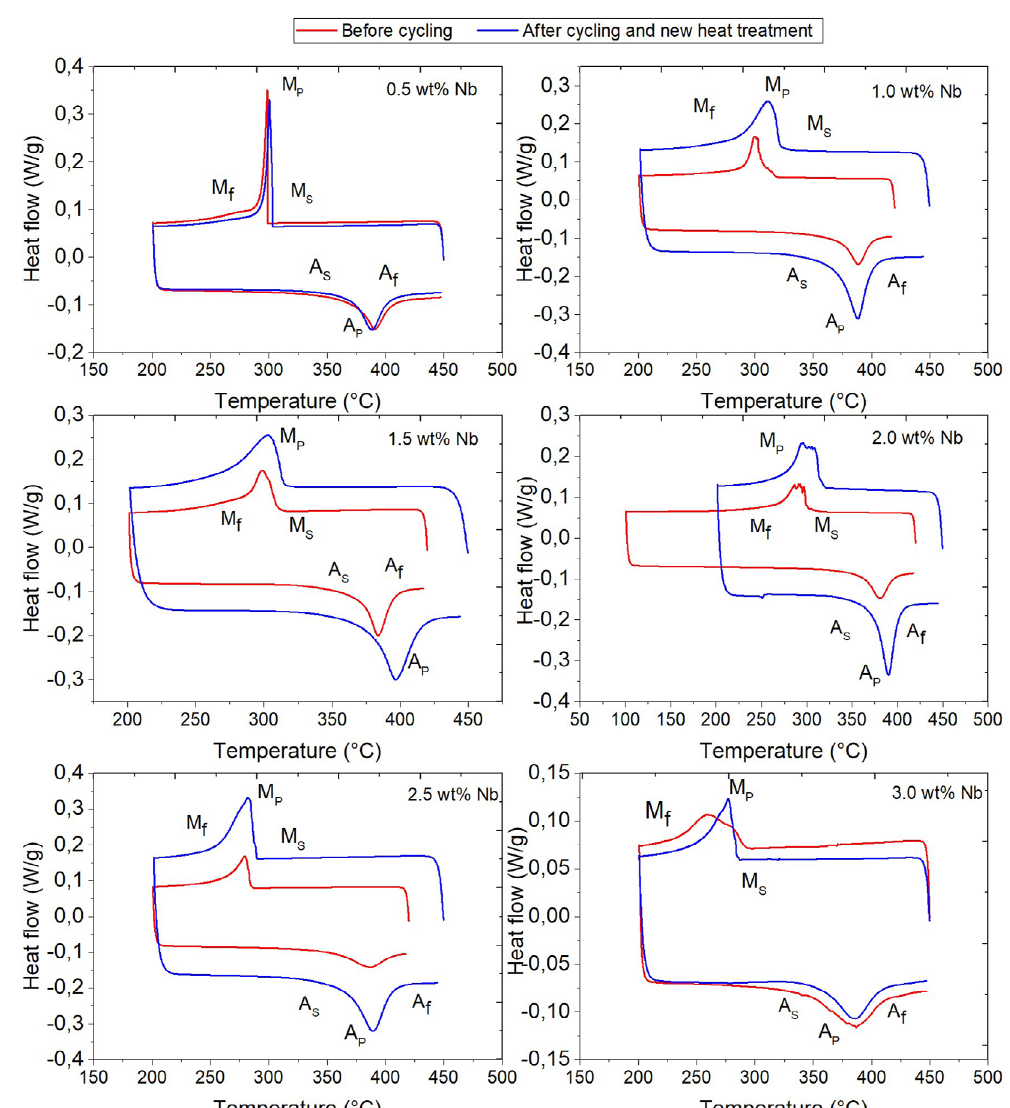
Figure 3. Superposition of DSC results before and after thermal cycling with phase martensitic transformation restoration through heat treatment for all Cu-Al-Nb HTSMA